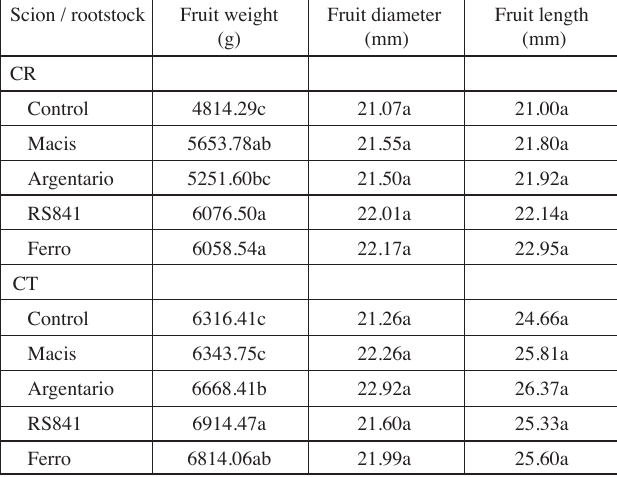
Tab. 1: Effects of rootstocks on fruits weight, diameter and length of ‘Crimson Tide’ (CT) and ‘Crisby’ (CR) watermelon fruits at harvest Scion / rootstock